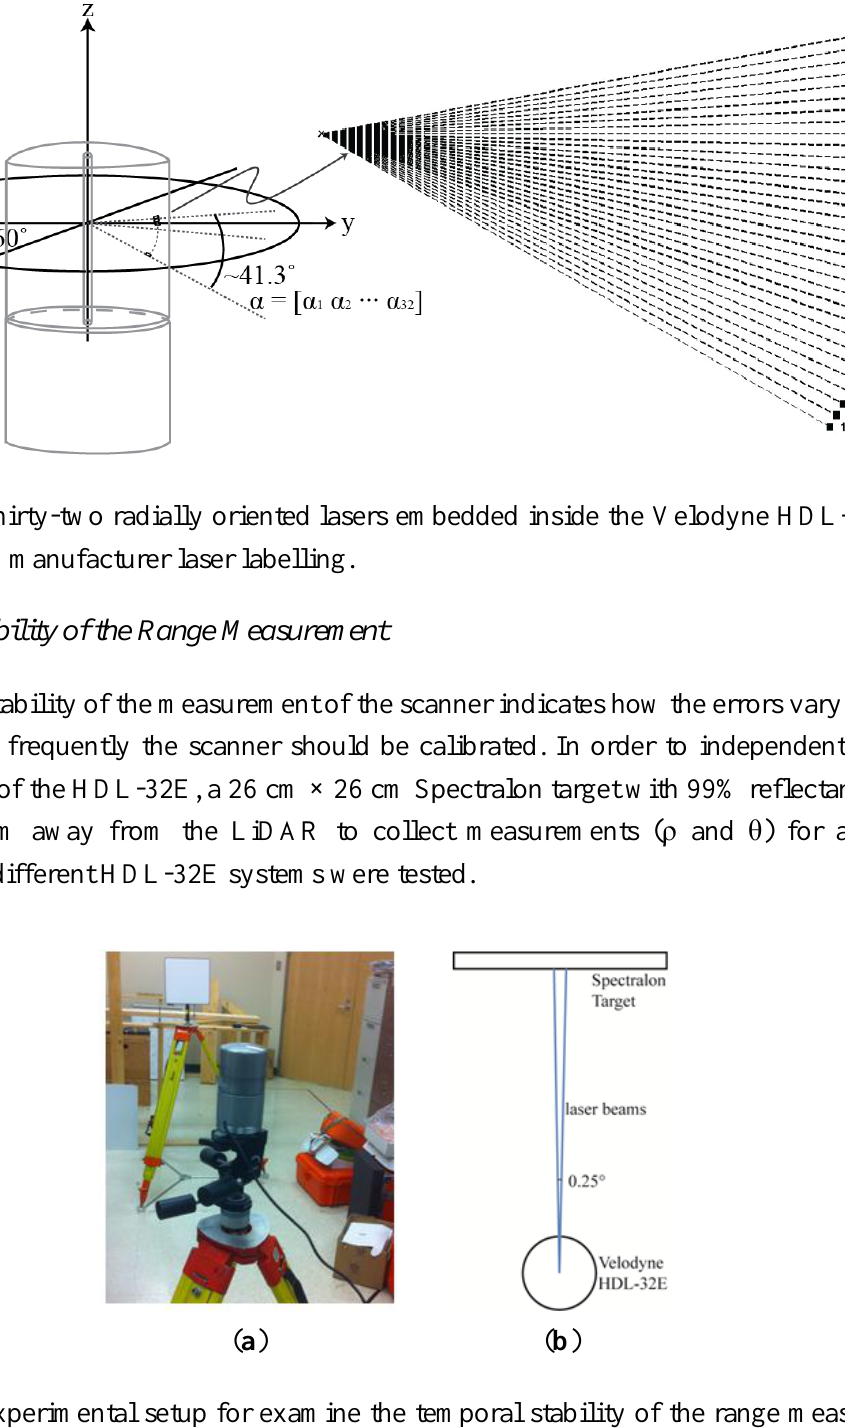
Figure 2. Experimental setup for examine the temporal stability of the range measurement ( a ) and its diagram on the xy-plane ( b ) for temporal stability